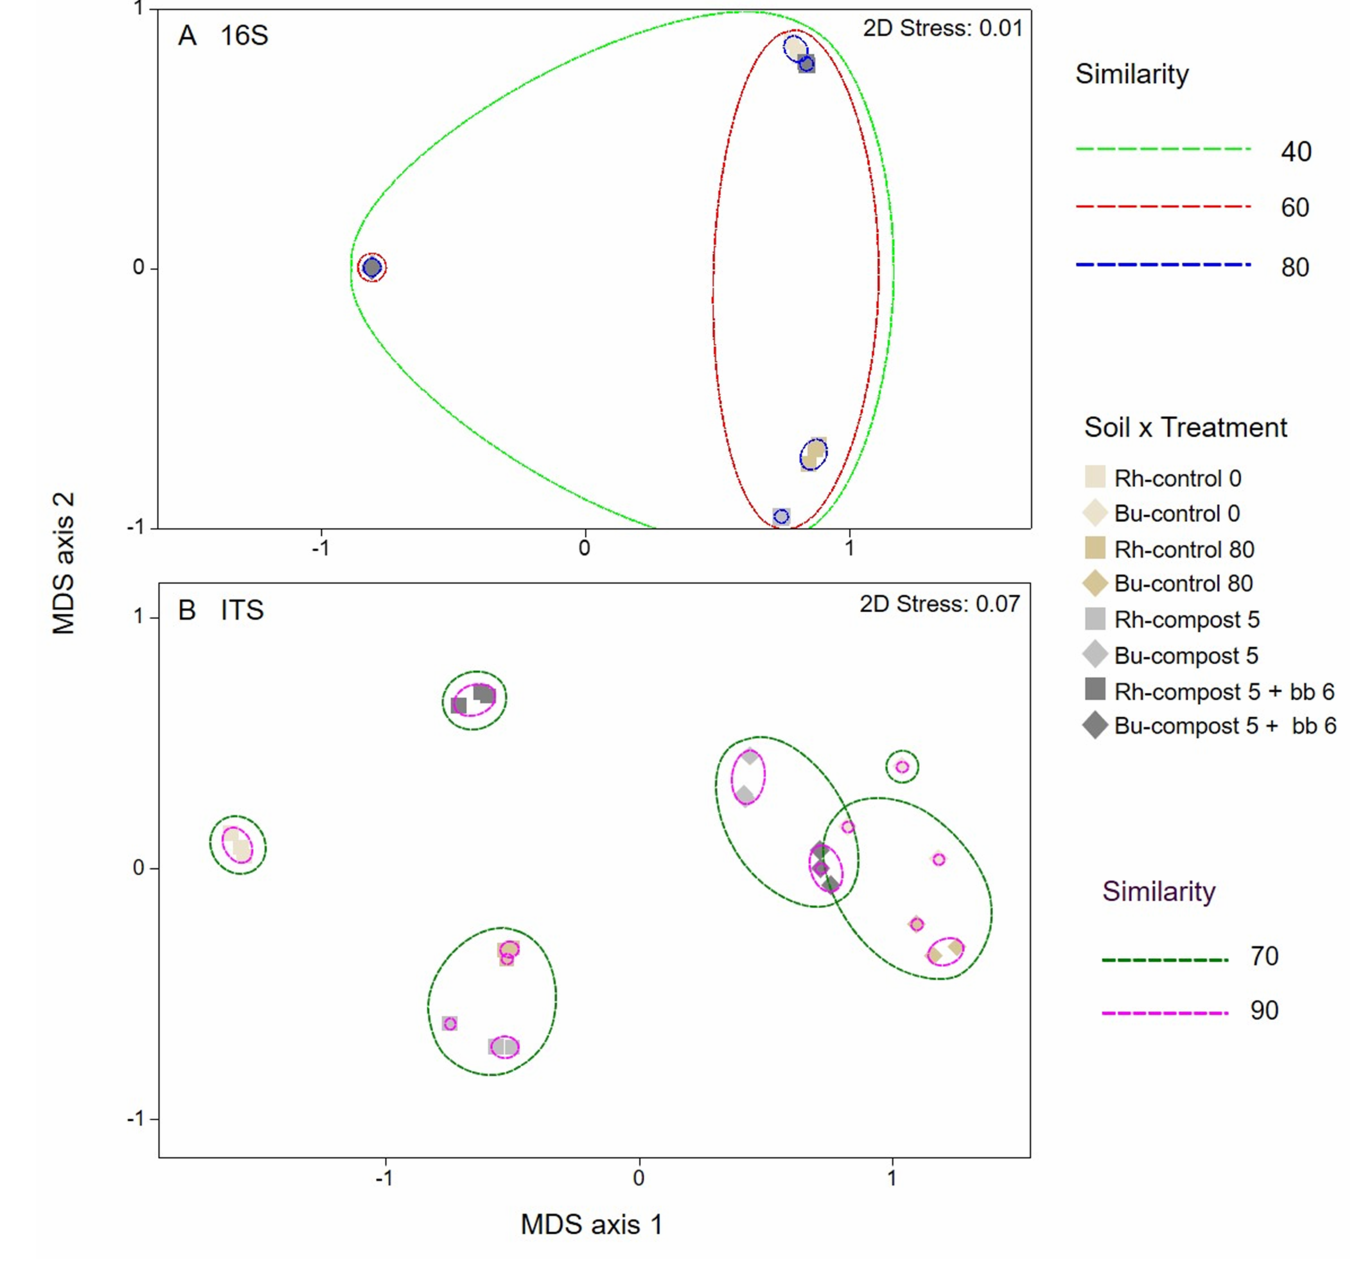
Figure 9. Non-metric multidimensional scaling (nMDS) plots of bacterial ( A ) and fungal ( B ) com- munities according to treatment applied. Each point represents the microbiome of one replicate of soil according to soil type. All rhombus shapes for bulk soil are placed on the left for the bacterial community ( A ) and on the right for the fungal community ( B ) in the figure. MDS axis 1 and MDS axis 2 represent the two axes of the two-dimensional ordination space. The stress level shown indicates how well the individual distances are represented (the closer to 0, the better are the original data points represented in the ordination space). All ordinations were performed using ASV-level data ( p = 0.001 based on